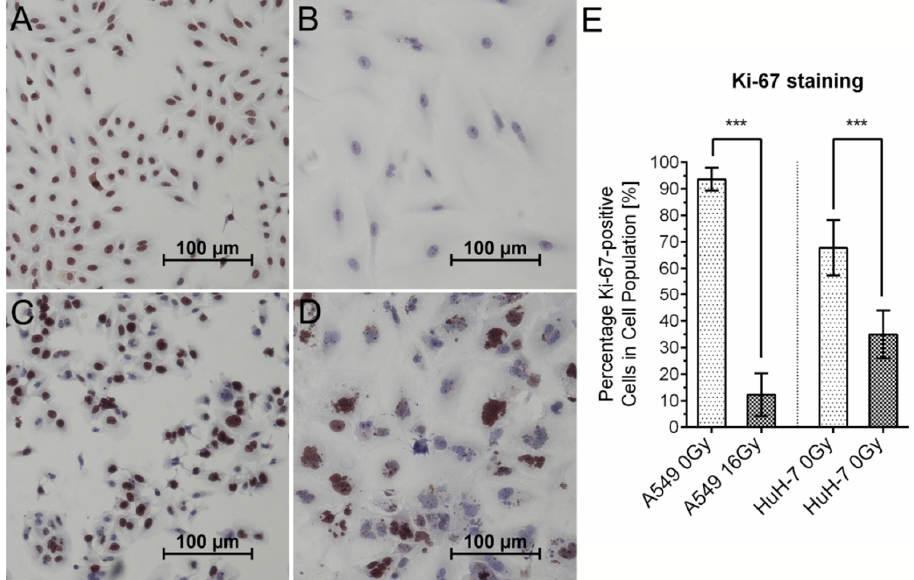
Figure 6. Decrease in Ki-67expression after irradiation. Representative images of A549 ( A , B ) and HuH-7 ( C , D ) cells stained immunohistochemically for Ki-67. Comparison of untreated control samples ( A , C ) and irradiated cells ( B , D ) revealed significantly decreased Ki-67 expression after irradiation ( E ). Mean values ± SD are shown, unpaired two-tailed t-test, comparison between untreated control cells and irradiated cells, *** p < 0.001.